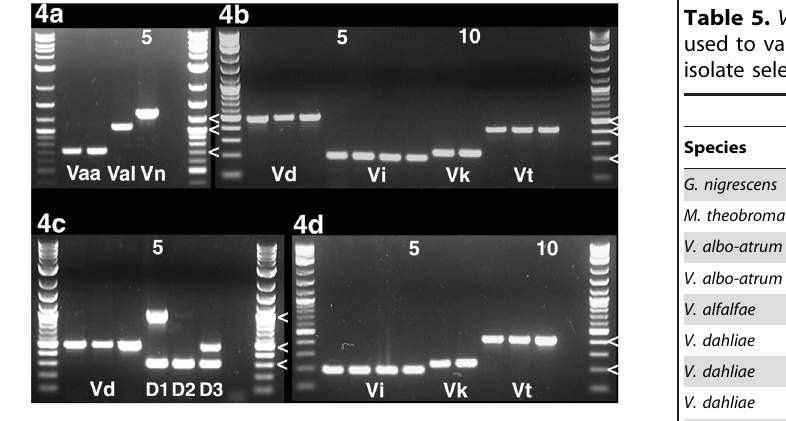
Figure 4. Multiplex PCR assays identify genetically diverse target isolates. Each agarose gel displays the results of one of the four multiplex PCR assays, controls with none-target isolates are shown in Figure S3. Gels are delimited by 2-log ladders, penultimate wells are negative controls, and relevant size markers are indicated by ‘ , ’. Lanes are numbered from left to right; numbers are given for every fifth lane. Abbreviations below bands indicate species and V. longisporum lineages as given for each part figure below. All lanes contain 100 ng template DNA. For an explanation of isolates included see text. 4a. Verticillium albo-atrum – V. alfalfae – V. nonalfalfae multiplex PCR assay. Lanes 2, 3: V. albo-atrum strains PD670, PD693. Lane 4: V. alfalfae strain PD338. Lane 5: V. nonalfalfae strain PD592. Size markers=700 bp,